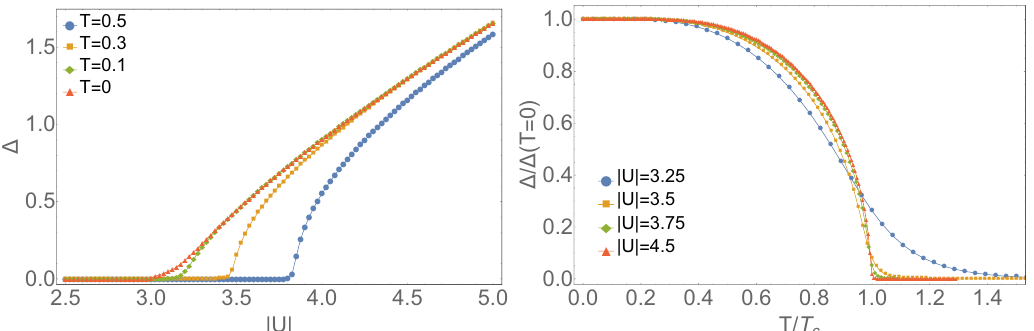
Figure 6: (color online) The meanfield pairing function ∆ for a Dirac Hamilto- nian (35) on a cylinder as a function of the interaction strength | U | (left panel), and the temperature T (right panel). We consider here a square lattice on a cylinder (open boundary conditions along x ) of lengths 100 × 100. In particular, we find that: (i) U increases with the temperature T (left), (ii) the temperature phase transition c is more evident when the interaction strength | U | increases (right). Near T = T for U (cid:29) U qualitatively recover the critial behavior known from the standard BCS c theory, see the main